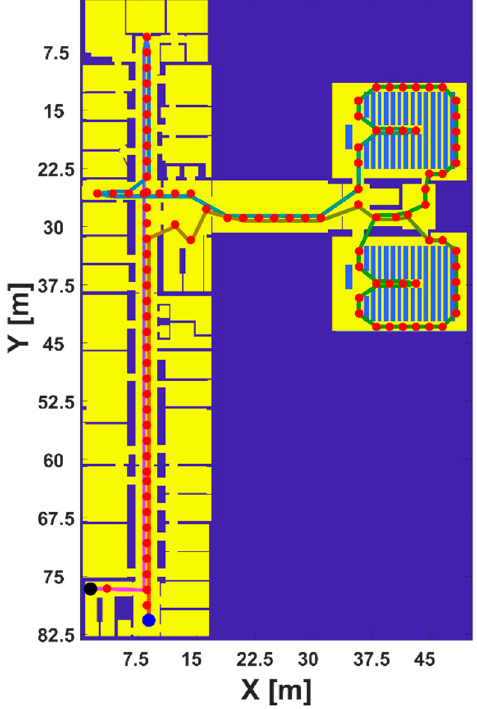
Figure 7. Building model with ground truth points (GTP) in red. The test runs started at GTP 1 (black) and ended at GTP 107 (blue). The path taken is approximately 583 steps or respectively 367 s long. The average walking speed was 1.6 m/s.